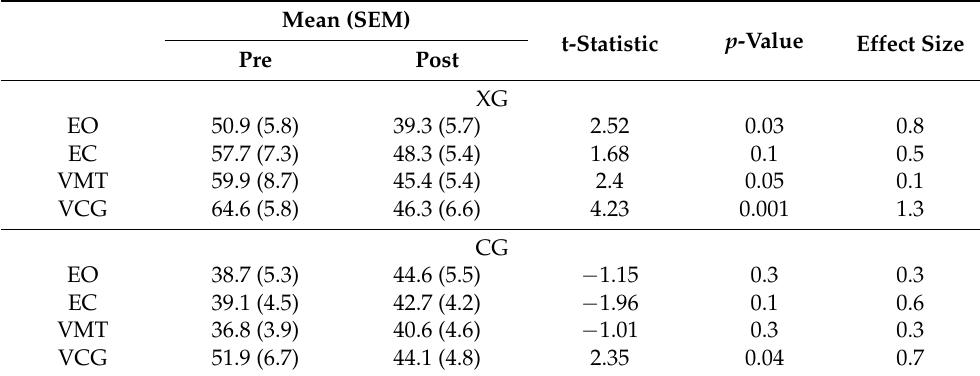
Table 7. Results of paired t-test of comparison between pre- and post-intervention COP-TPL. Pre- sented are group, means and standard errors of means (SEM), t-statistic, p -value, and effect size. Mean (SEM) t-Statistic p -Value Effect Size Pre Post